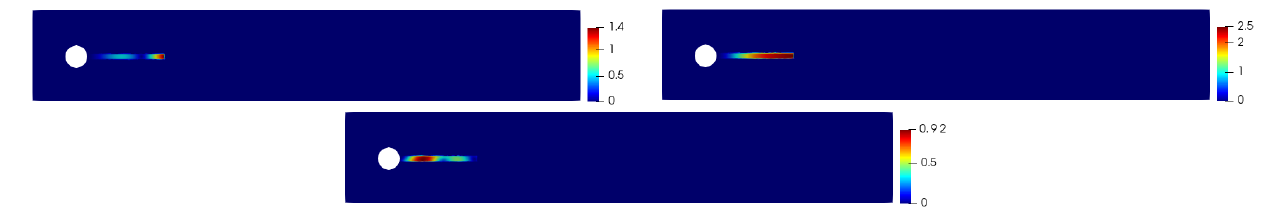
Figure 7. The first three POD modes for the solid displacement d s